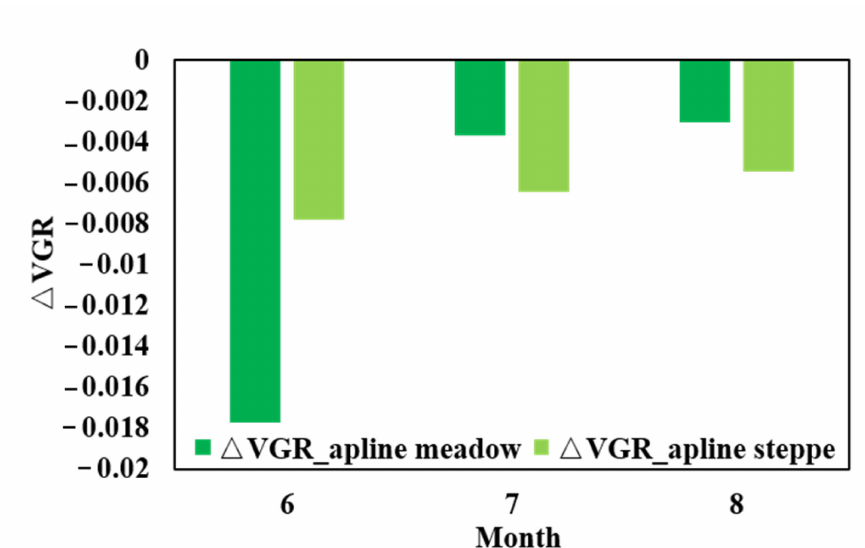
Figure 11. ∆ VGR in each month in June, July, and August on the Tibetan Plateau from 2000 to 2020. The dark green column represents the ∆ VGR of the alpine meadow; the light green column indicates the ∆ VGR of the alpine